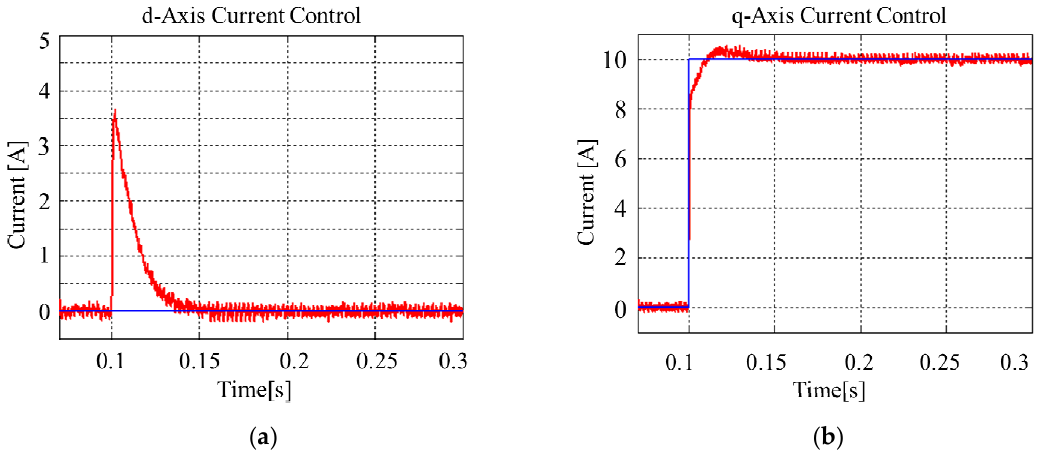
Figure 4. Simulation results for current control: ( a ) d-axis; ( b ) q-axis.